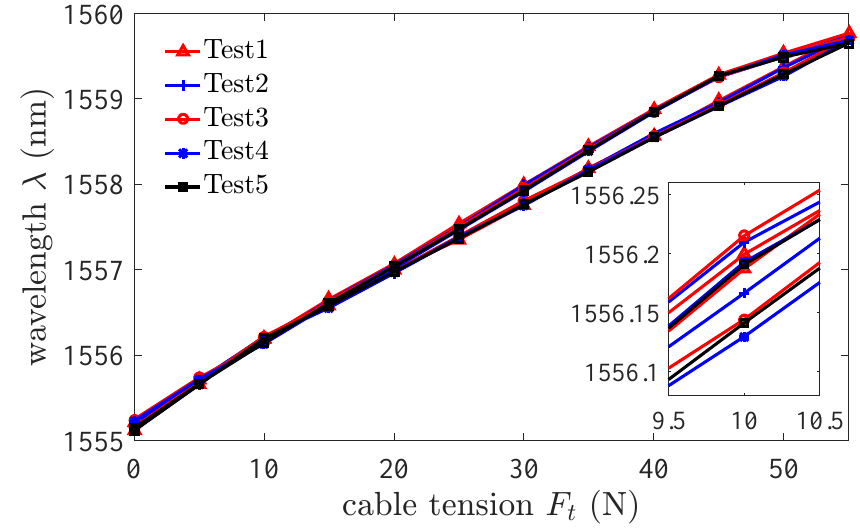
Figure 11. The wavelength λ changes with the cable tension F t in the direction of increasing input and in the direction of decreasing input.